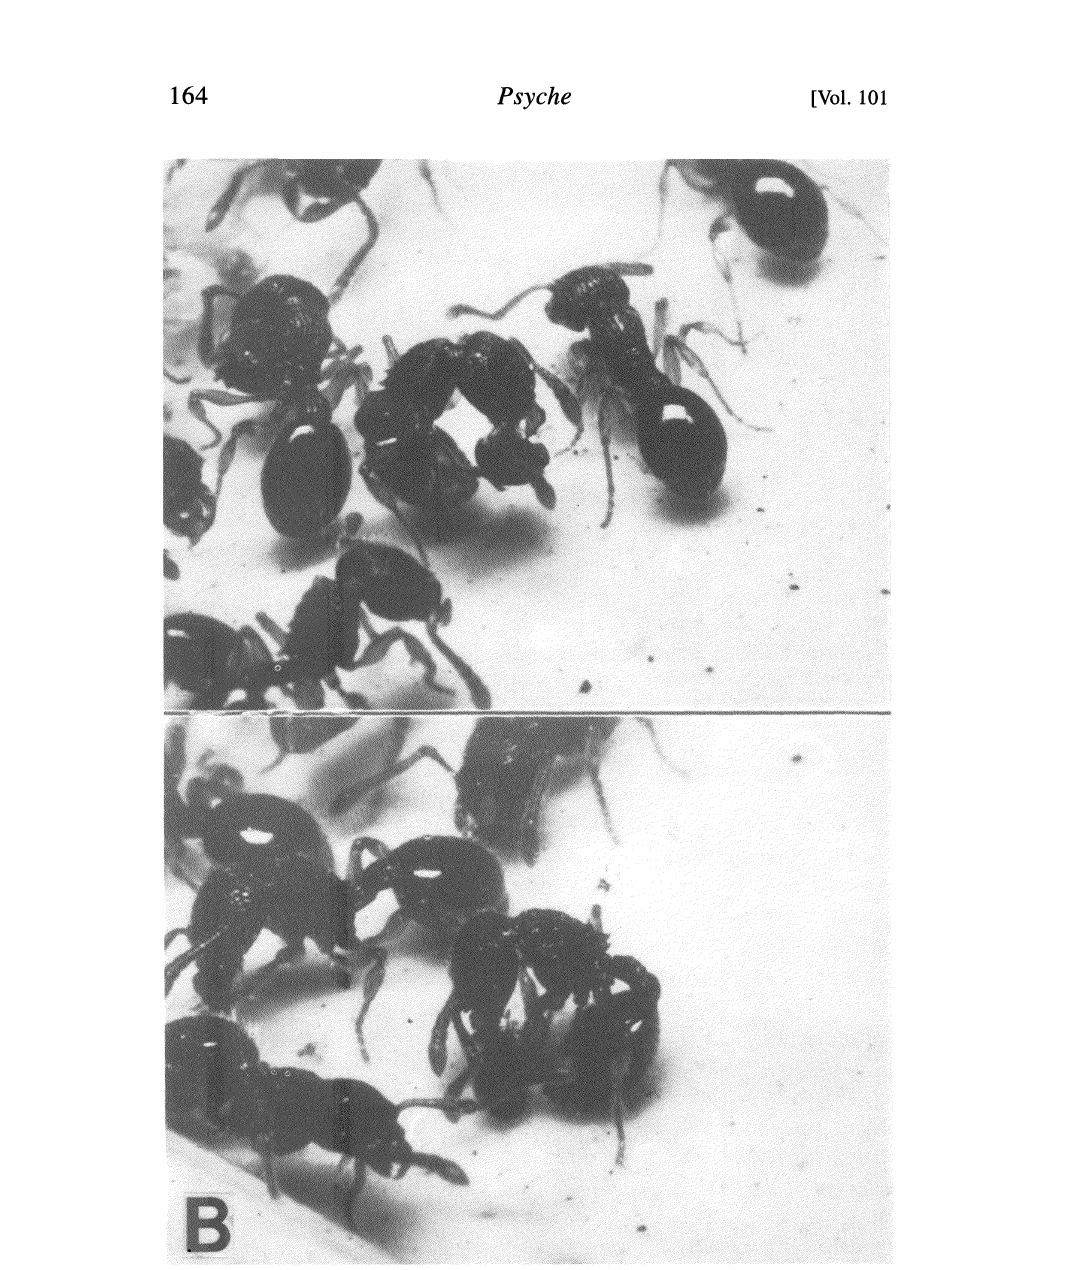
Fig. 3. A, B: Workers of M. g. nipponica dismembering oribatid mites in a labo- ratory nest. Note that the ant’s gaster is bent forward but not brought into contact with the